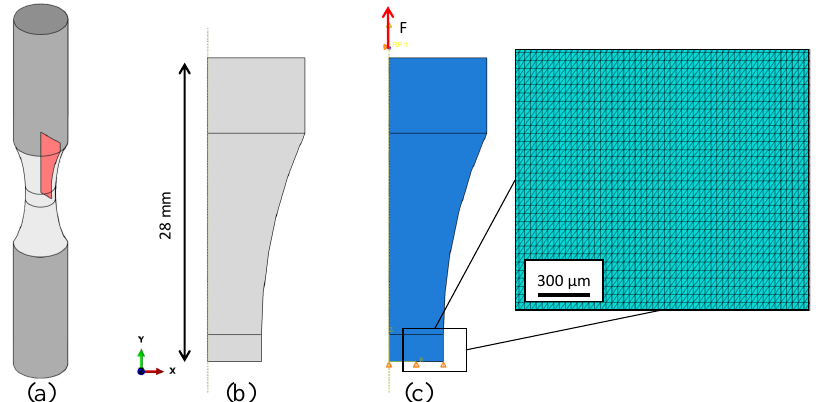
Figure 8. Scheme of the FE model adopted for the simulation of residual stress cyclic relaxation: ( a ) axial-symmetric model highlighted in red respect to the whole specimen; ( b ) main dimension of the part adopted in the simulation and ( c ) load, constraints and mean mesh size adopted.